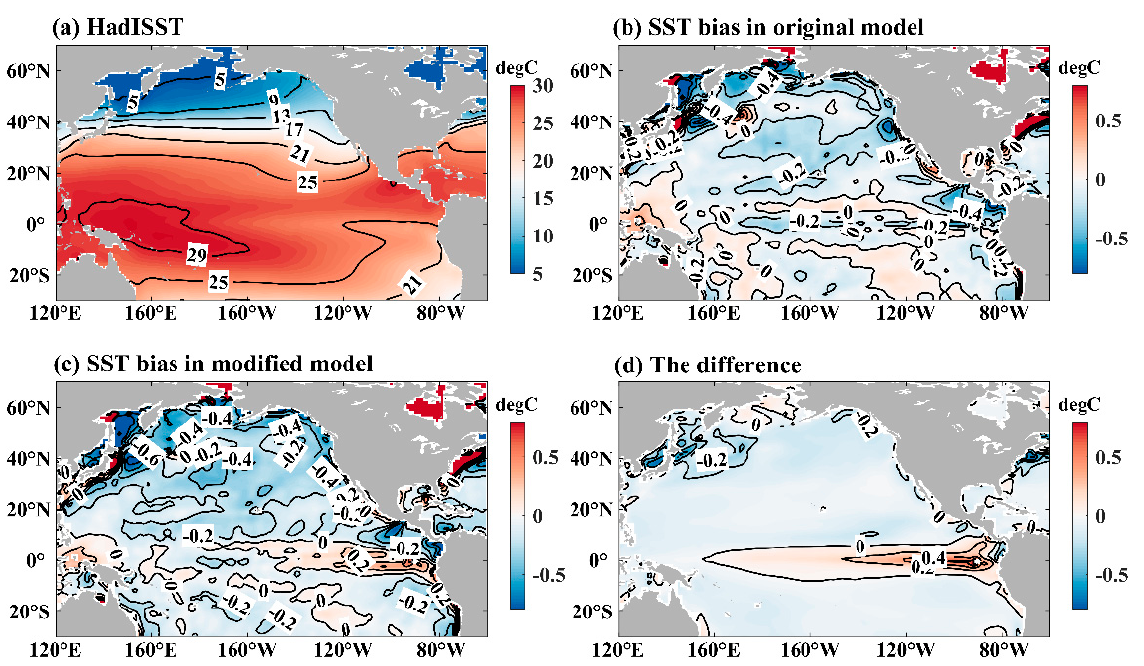
Figure 7. The climatological SST (( a ) , units: °C), SST biases in original ( b ), modified FIO − ESM − CPS ( c ) and the difference of SST biases between modified and original FIO − ESM − CPS ( d ).